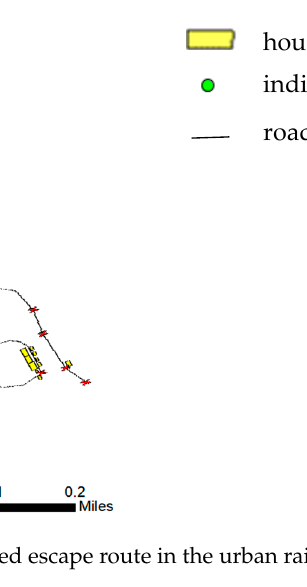
Figure 6. Map of the simulated escape route in the urban rainstorm context.